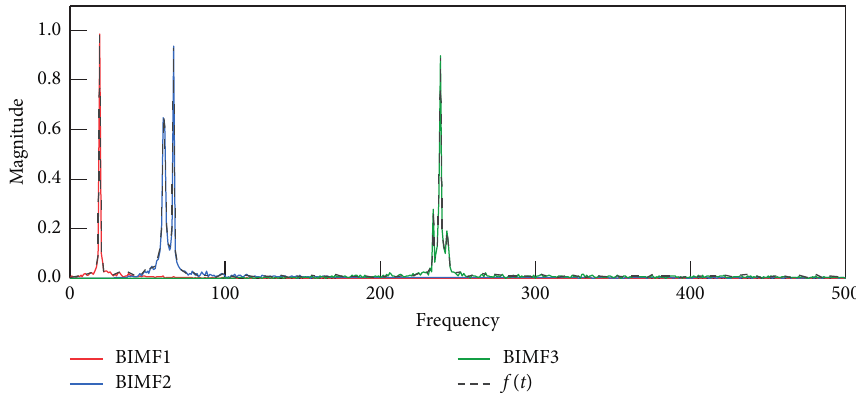
Figure 3: Comparison of BIMF frequency between source signal and VMD